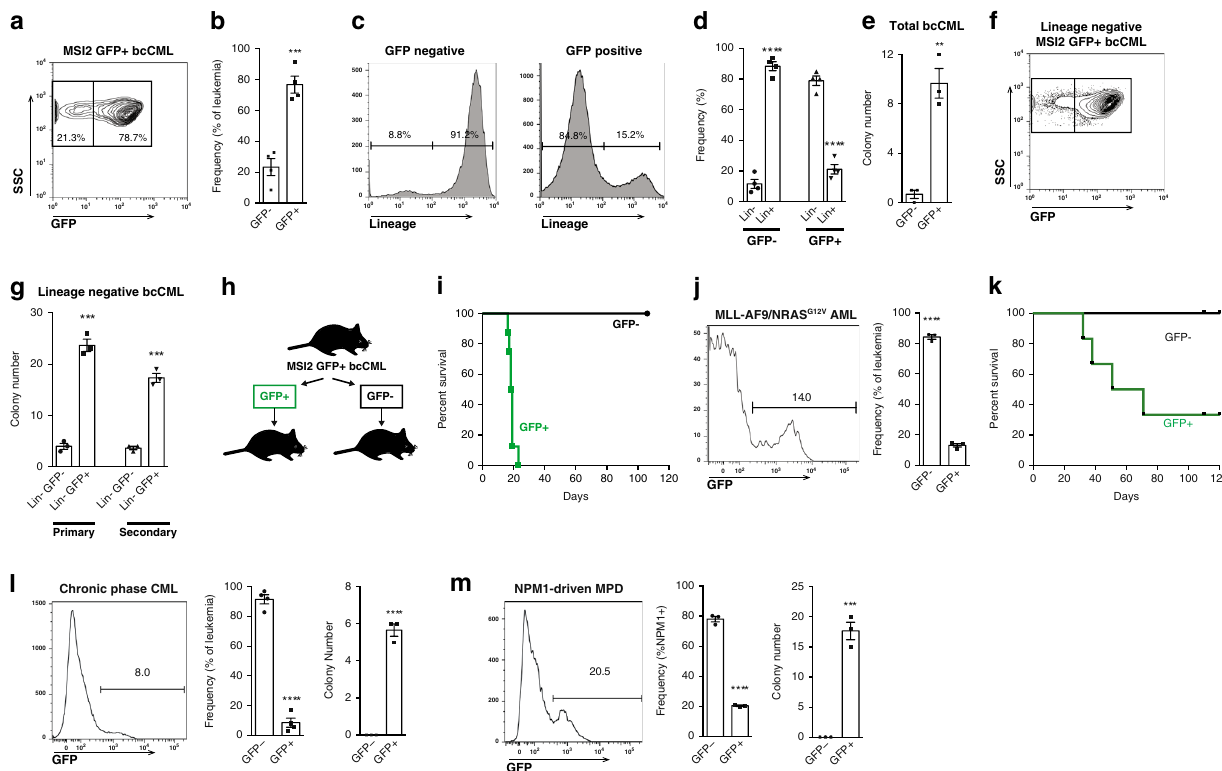
Fig. 1 Msi2 marks leukemia stem cells in a mouse model of bcCML. a Representative FACS plot shows GFP expression in Msi2-reporter bcCML. b Average frequency of GFP − negative (GFP − ) and GFP-positive (GFP + ) leukemic spleen cells *** P = 0.0005 ( n = 4 mice). c Representative histograms show lineage expression in GFP − and GFP + leukemic spleen cells. d The average frequency of lineage-negative (Lin − ) and lineage-positive (Lin + ) cells within either the GFP − or GFP + fraction **** P < 0.0001 ( n = 4 mice per group). e Number of colonies generated from GFP − and GFP + bcCML cells. ** P = 0.002 ( n = 3 technical replicates). f Representative FACS plot shows GFP expression within the lineage-negative (Lin − ) fraction of the spleen from a leukemic mouse. g Number of colonies generated from Lin − GFP − and Lin − GFP + bcCML cells after primary and secondary plating. *** P = 0.0001 ( n = 3 technical replicates each). h Schematic illustrates an experimental approach to test the ability of established GFP + and GFP − bcCML cells to drive disease development in secondary recipient mice. GFP + or GFP − cells from established bcCML were transplanted into recipients and i survival was monitored ( n = 8 for GFP + and n = 10 for GFP − ). j The representative histogram shows GFP expression in leukemic spleen cells from a mouse with MLL-AF9/NRAS G12V - driven AML (left panel); frequency of GFP − and GFP + leukemic spleen cells from mice with MLL-AF9/NRAS G12V -driven AML **** P < 0.0001 (right panel; n